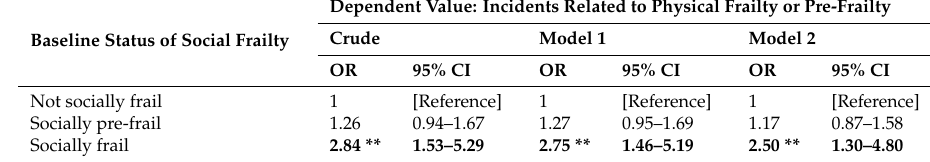
Table 3. Odds ratios for the development of physical frailty or pre-frailty after four years, with reference to baseline social frailty status among older adults without physical